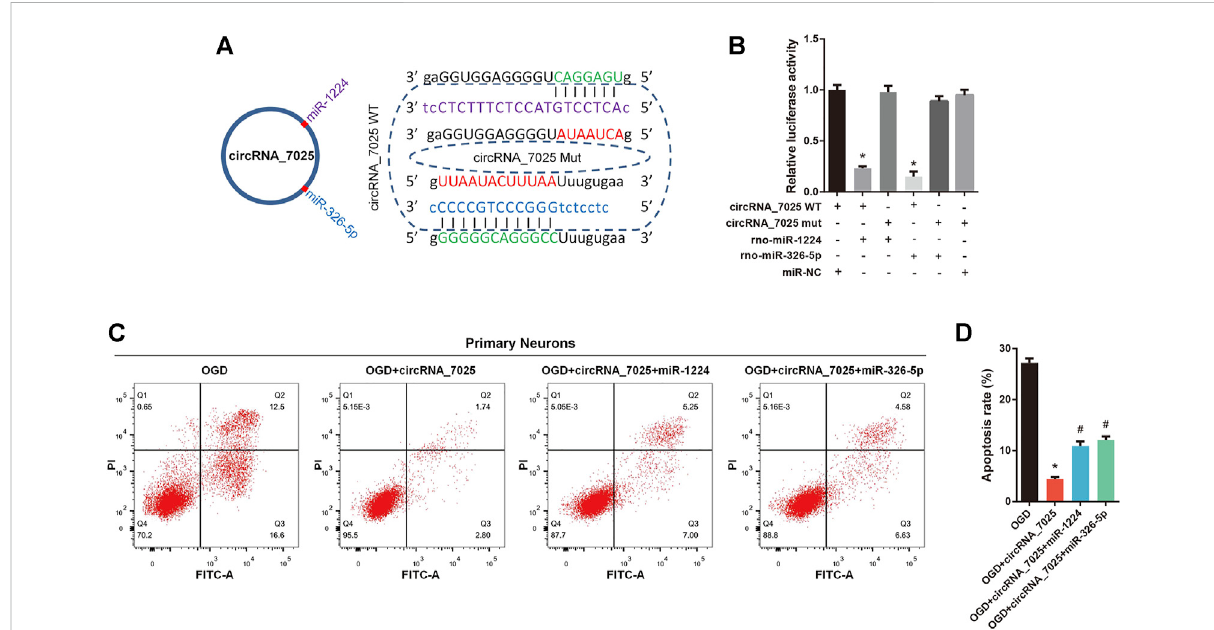
FIGURE 8 circRNA_7025 protects against neuronal apoptosis via thecircRNA_7025- rno-miR-1224/rno-miR-326-5p axis. (A) Schematic diagrams ofthe predicted bindingsitesbetween circRNA_7025, rno-miR-1224andrno-miR-326-5p,andconstructionofcircRNA_7025wild-type (WT) andmutant (Mut)luciferasereportervectors. (B) LuciferasereporterassayforcircRNA_7025orcircRNA_7025mutantcotransfectedwithrno-miR-1224andno- miR-326-5p mimics (* p < 0.05, n = 3). (C) Neuronal apoptosis was measured using fl ow cytometry. (D) The results of fl ow cytometry are presented as the apoptosis rate (* p < 0.05 vs. OGD group, # p < 0.05 vs. circRNA_7025 group, n = 3). OGD, oxygen and glucose